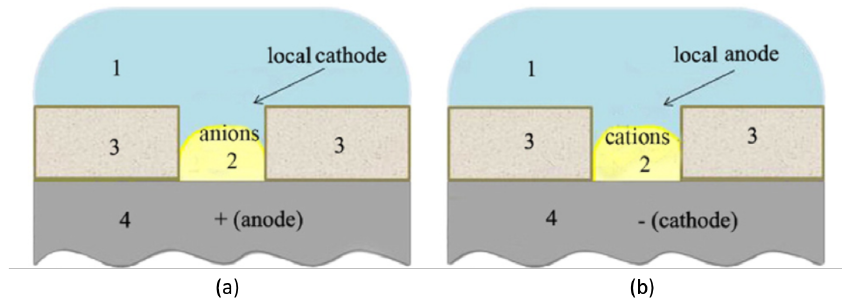
Figure 5. Local cathode ( a ) and anode ( b ) obtained under current AC during a MAO